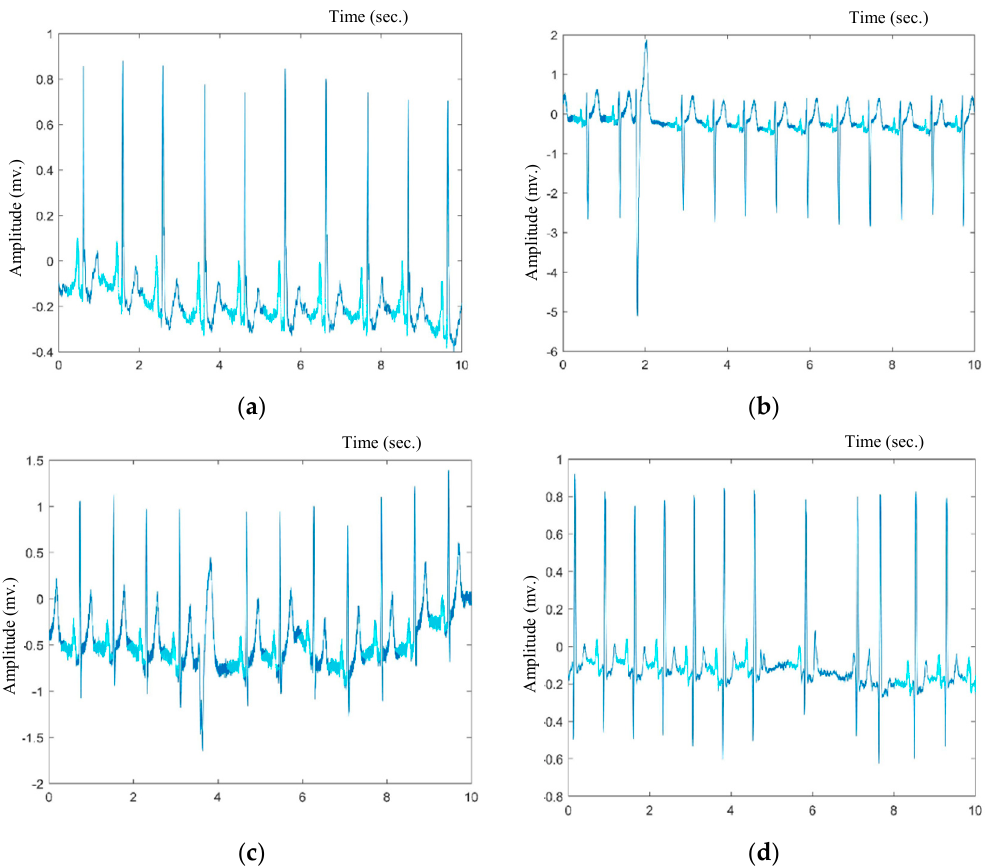
Figure 1. Samples of manually annotated P-waves in the MIT-BIH AF database for normal beats. ( a ) 05091 record; ( b ) 08405 record; ( c ) 08455 record; and ( d ) 08215 record, where the light blue areas represent P-wave duration.